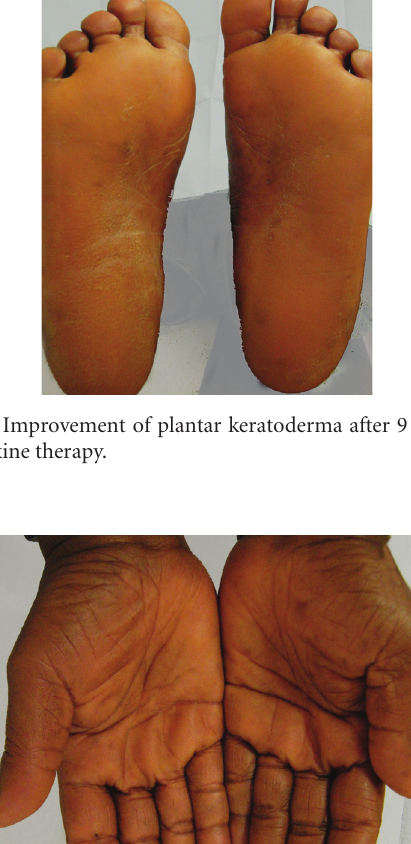
Figure 2: Di ff use palmar keratoderma with a yellowish hue.